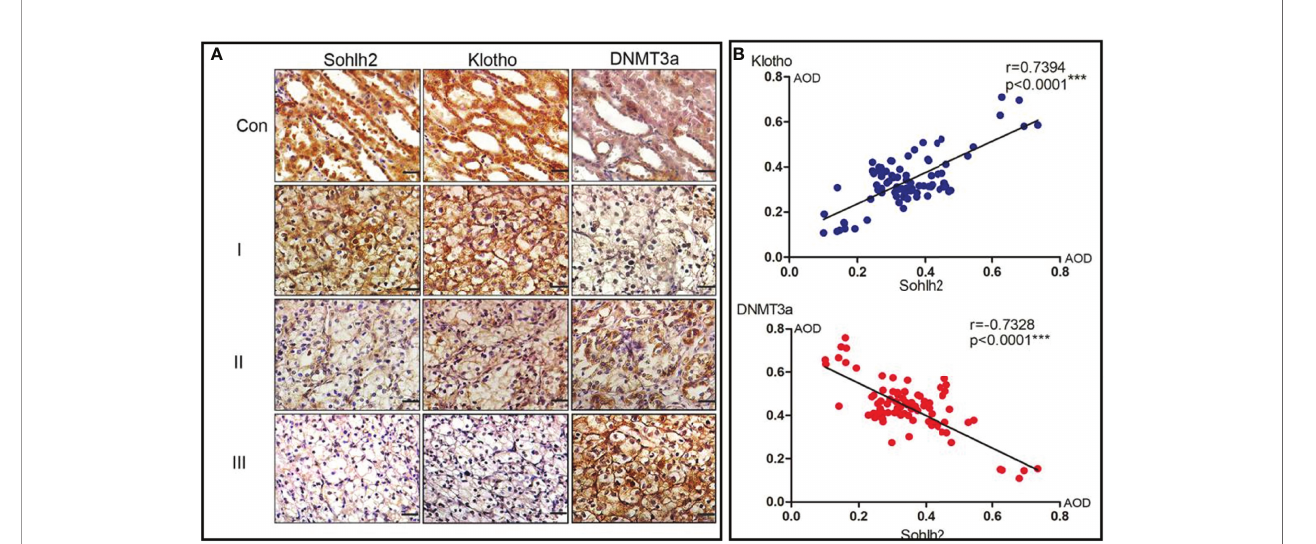
FIGURE 6 | Correlation analysis of Sohlh2, Klotho, and DNMT3a in human RCC tissues. (A) Immunohistochemical staining results of Sohlh2, DNMT3a, and Klotho in human RCC samples. (B) Statistical analysis results of panel (A) RCC, renal cell carcinoma. (***P < 0.0001, which is statistically signi fi